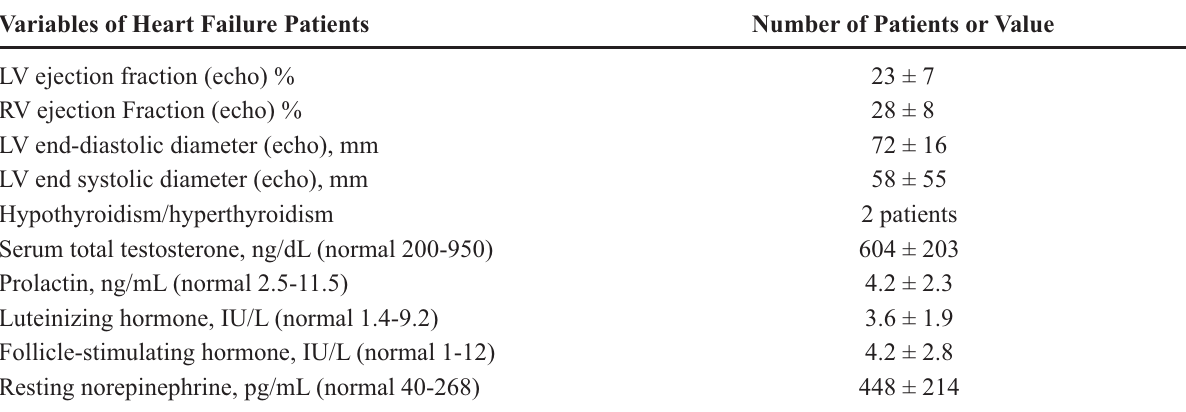
Table 2 – Cardiac function, left ventricular diameters and hormonal values in patients with erectile dysfunction.